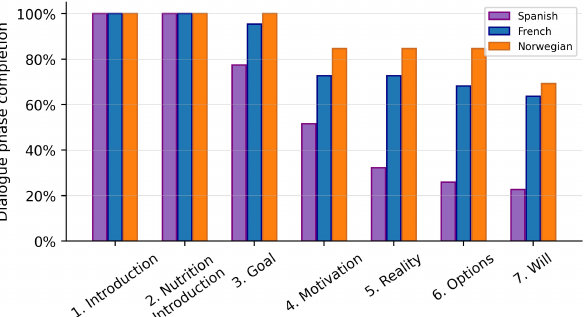
Figure 13. Percentage of dialogue phases the system successfully completed on average, per